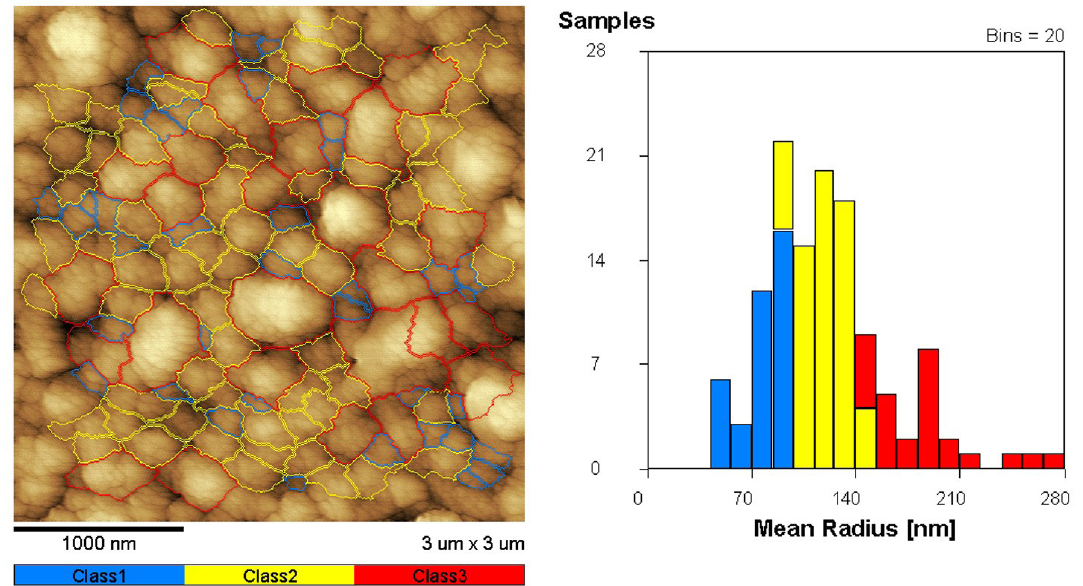
Figure 3. AFM on (3 × 3) µm scan of the porous TiO